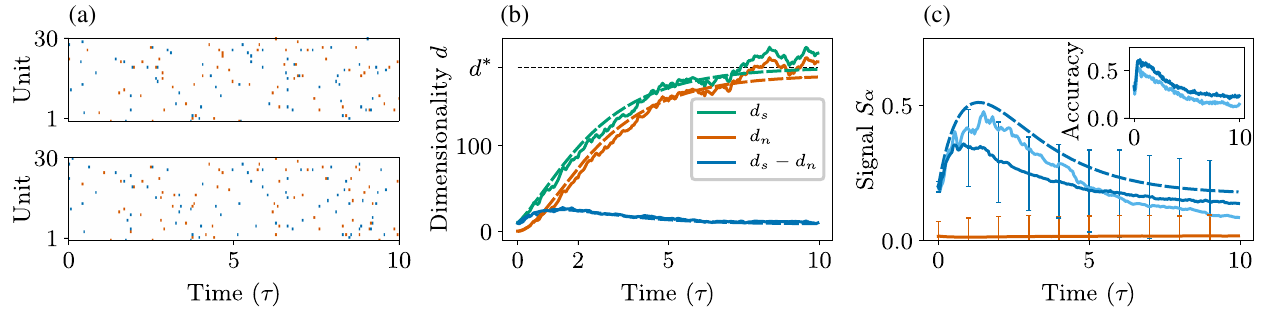
FIG. 7. Transient dimensionality expansion of stimulus representation by a chaotic binary network. (a) Time evolution of the first 50 neurons for two different patterns of initial states; up transitions in red, down in blue. Initial state of first L ¼ 10 neurons set to one of the P ¼ 50 fixed, random patterns. The initial state of the remaining neurons is kept constant. (b) Evolution of signal and noise subspace t Þ given by Eq. (17) explored by the network across different patterns [green solid curve, using dimensionality. Dimensionality d s ð t Þ explored across different averaged simulated distances across all pairs of patterns; dashed curve, theory (19)]. Dimensionality d n ð noisy realizations of a pattern [dark orange solid curve, using averaged simulated distances across all pairs of 20 realizations per pattern; dashed curve, theory (19)]. Noisy realizations of patterns have Gaussian noise with standard deviation σ ¼ 0 . 3 added to each of the L entries of the initial pattern state. Difference between signal and noise dimensionality (blue, theory is dashed). (c) Linear readout ξ S α 0 ð t Þ ¼ w α 0 ð t Þ T ½ x α ð t Þ þ ξ trained for each time point t to detect stimulus identity by minimizing the quadratic error P pre (cid:2) þ post 2 for the correct stimulus α ¼ α 0 (blue) and nonmatching stimuli α ≠ α 0 (dark orange). Error bars show the variability − δ αα 0 Þ α ð S α 0 . Theoretical prediction (28) (dashed blue). Readout by the theoretical weight across patterns and noise realizations, excluding ξ post vector (A47) using the approximation (A50) (light blue). Inset: classification accuracy of the initial input stimulus based on choosing the readout with largest signal for trained readouts (blue) and approximate readouts (light blue), including ξ . The approximate readout post vectors yield a higher average signal, but also the variance is higher (not shown) resulting in slightly worse classification accuracy. Other 0 . 1 , and postreadout noise σ 0 . 1 as detailed in parameters: N ¼ 500 neurons, coupling strength g ¼ 0 . 8 , prereadout noise σ ξ ξ ; post ¼ ; pre ¼ the Appendix 10. The training set comprised 100 noisy realizations of each pattern and the test set 20. All theoretical curves are corrected for the probability that a noise realization does not leave the original flux tube; see the Appendix 10